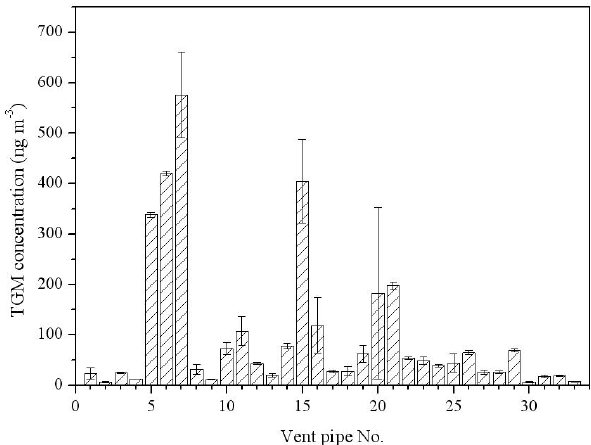
Fig. 8. Average TGM concentrations in the LFG at G-Y (vent pipe No. 1–27) and J-K (vent pipe No. 28–33) landfill, the error bars denote ± 1 SD in the measured